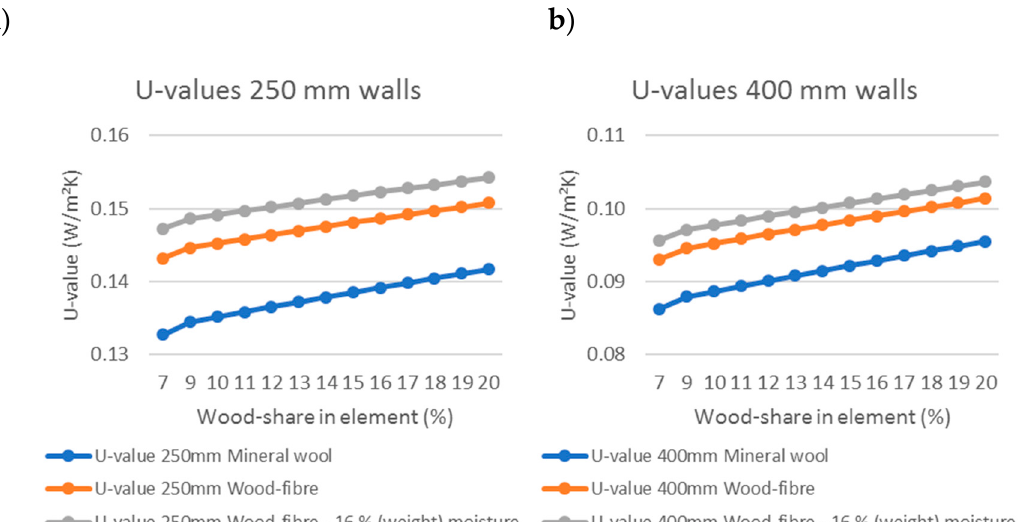
Figure 6. Wood-share and moisture effects on the thermal transmittance (U-value) of the 250 mm